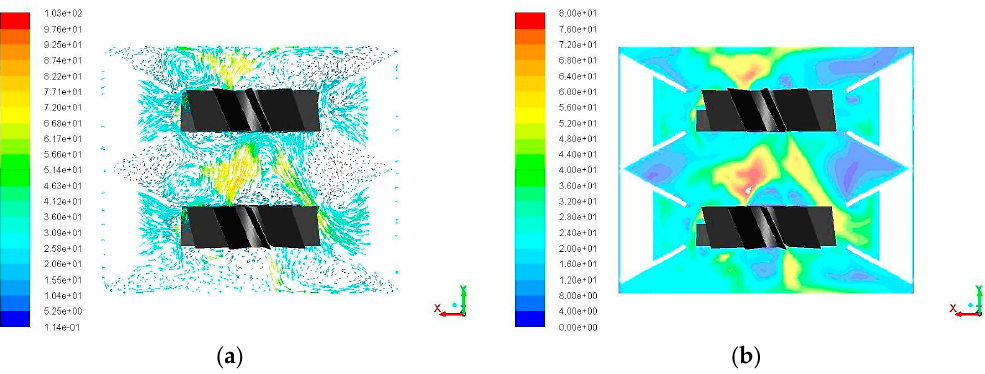
Figure 17. ( a ) Velocity vectors (m/s); ( b ) contours of velocity (m/s) on xy plane and the center of the rotor for two-stage KIONAS, rotor blade angle of 30° and stator with curved guide vanes.